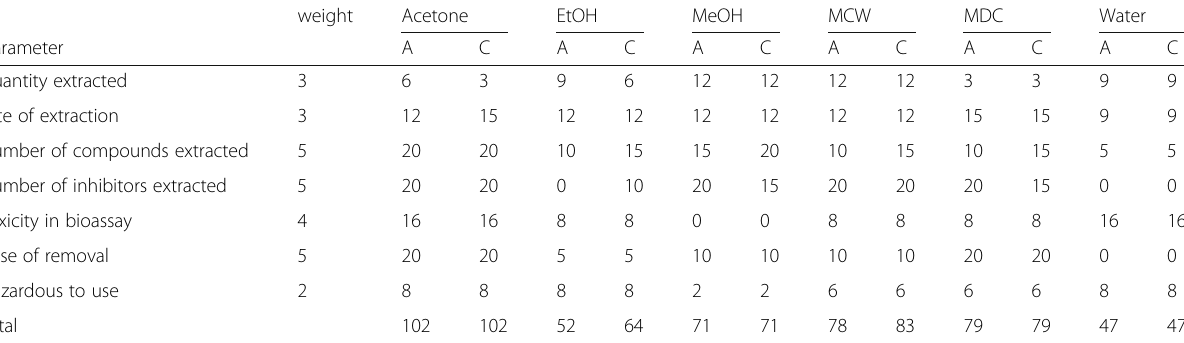
Table 1 Comparison of extractants on different parameters based on a five point scale [0 – 4] and with different weights allocated to the different parameters. [A = results for Anthocleista grandiflora and C = results for Combretum erythrophyllum